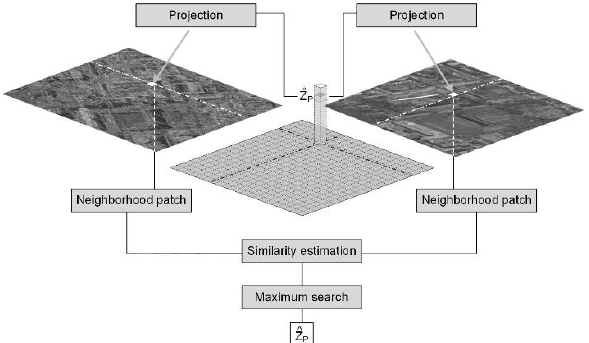
Figure 1. Sketch of the object space-based stereogrammetric fusion procedure. Starting from height hypotheses in the voxelized object space, the corresponding image points are determined by back projection using range-Doppler equations for SAR and central